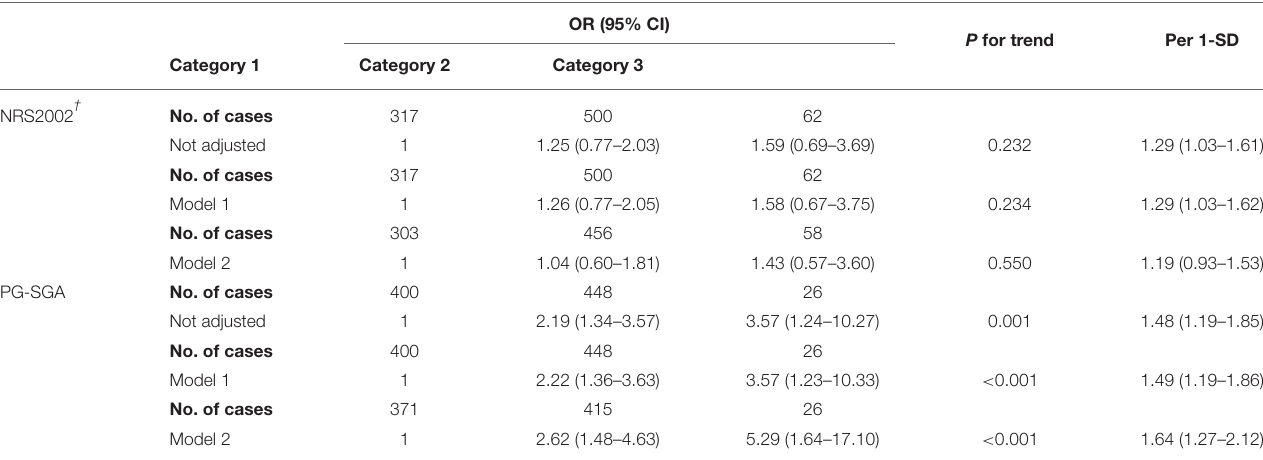
TABLE 3B | The association of NRS2002 and PG-SGA with post-operative infections (CRC).